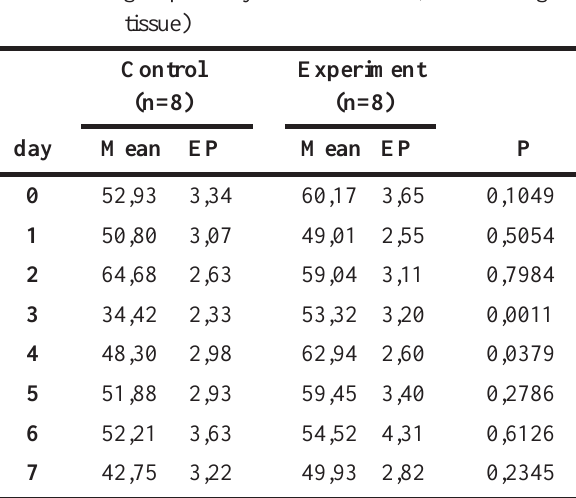
TABLE 1 – Mean fl ow values in experimental and control group. Daily measurement (ml/min/100g of